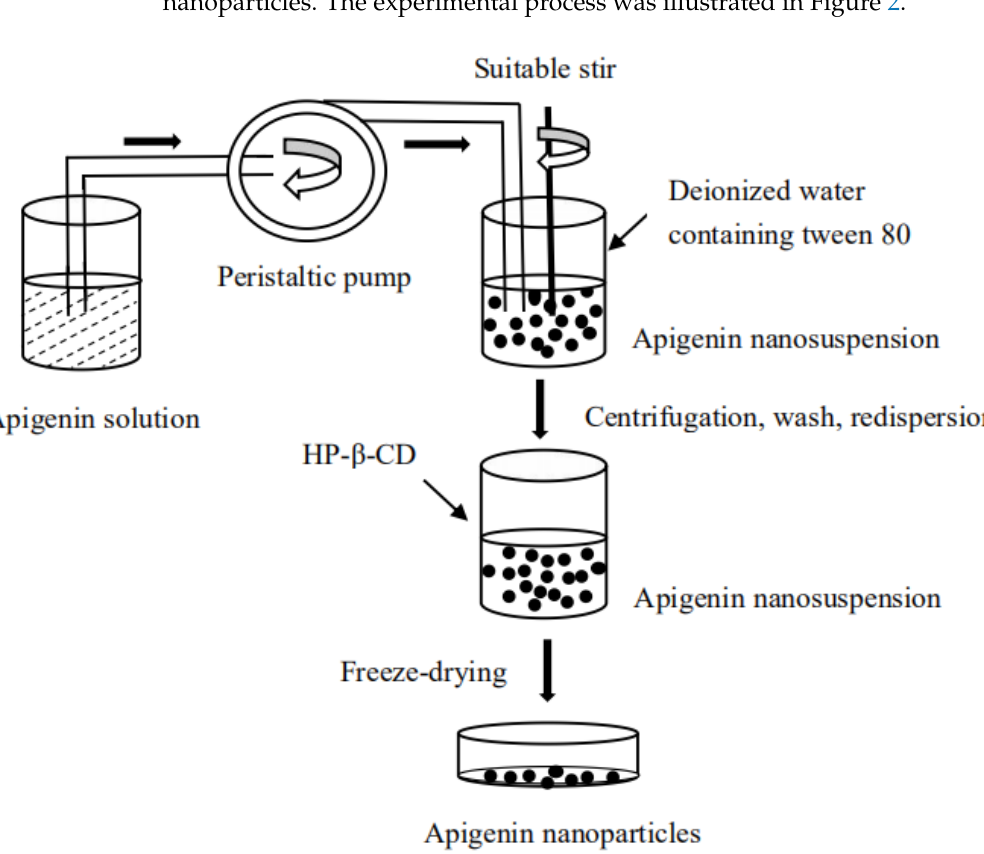
Figure 2. Diagram of apigenin nanoparticles’ preparation process.